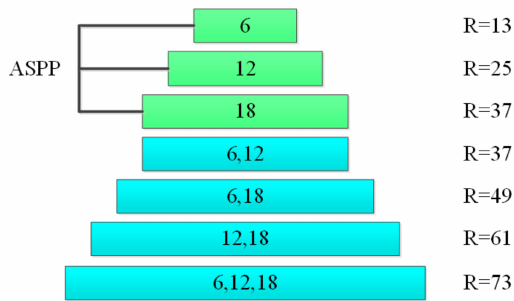
Figure 6. Receptive field of dense